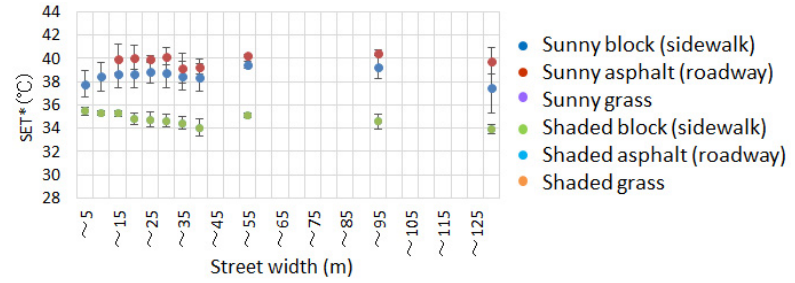
Figure 14. Relationship between street width and SET* at 1.5 m height at 1:00 p.m. on 5 August 2019 on east-west road. The plot is the averaged value, and the vertical bar on each plot is the standard deviation in the street width section.